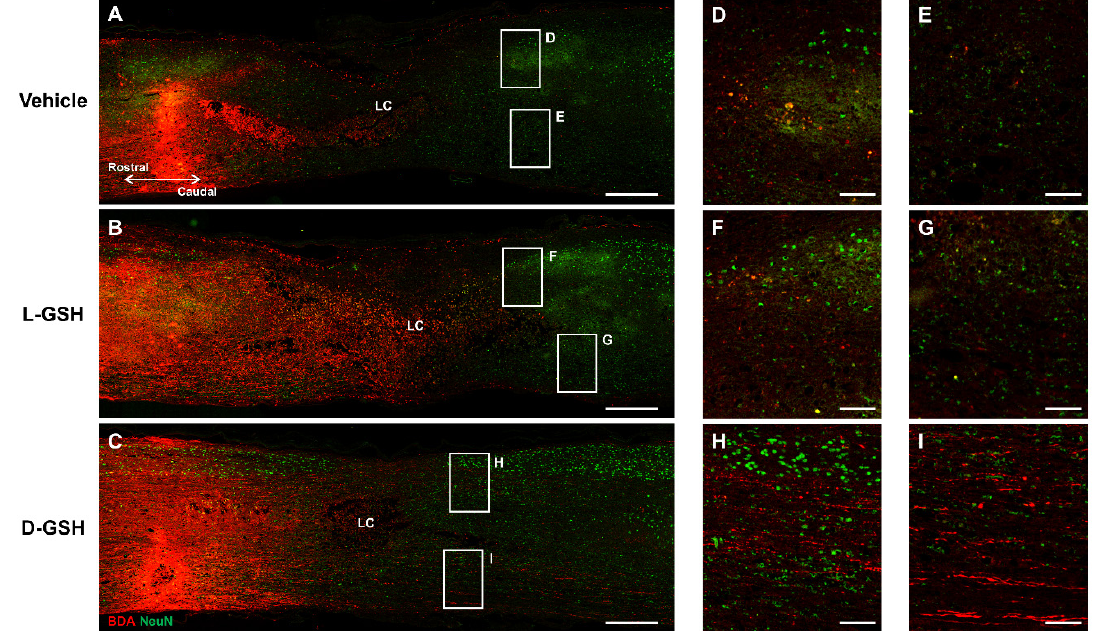
Figure 5. BDA-labelled axons in composite tiled scans of sagittal sections stained for neuron (anti-NeuN, Green), axon (anti-streptavidin, Red). LC, lesion center. Representative images of the ( A ) vehicle group, ( B ) L-GSH group, and ( C ) D-GSH group after SCI in rats. ( D , E ) Higher magnification of boxed areas past the lesion center from ( A ). ( F , G ) Higher magnification of boxed areas past the lesion center from ( B ). ( H , I ) Higher magnification of boxed areas past the lesion center from ( C ). Scale bar, 500 μ m ( A – C ) and 100 μ m ( D – I ).